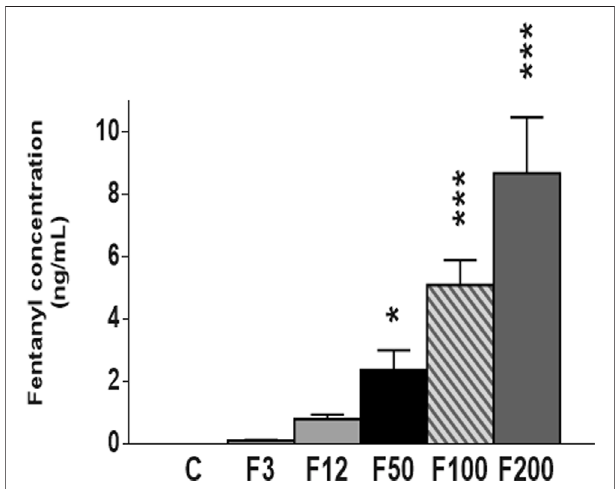
FIGURE 2 | Fentanyl concentrations in plasma of rat pups were determined at postnatal day 22 (P22) by ultrahigh-performance liquid chromatography (UPLC)/triple quadrupoledetector(TQD). FromF50,fentanyl was detected in the plasma in a measure-dependent way (F50 < F100 < F200). F3: fentanyl ® (F) 3 μ g/kg/h ( n = 10), F12: 12 μ g/kg/h ( n = 12), F50: 50 μ g/kg/h ( n = 9), F100: 100 μ g/kg/h ( n = 11), F200: